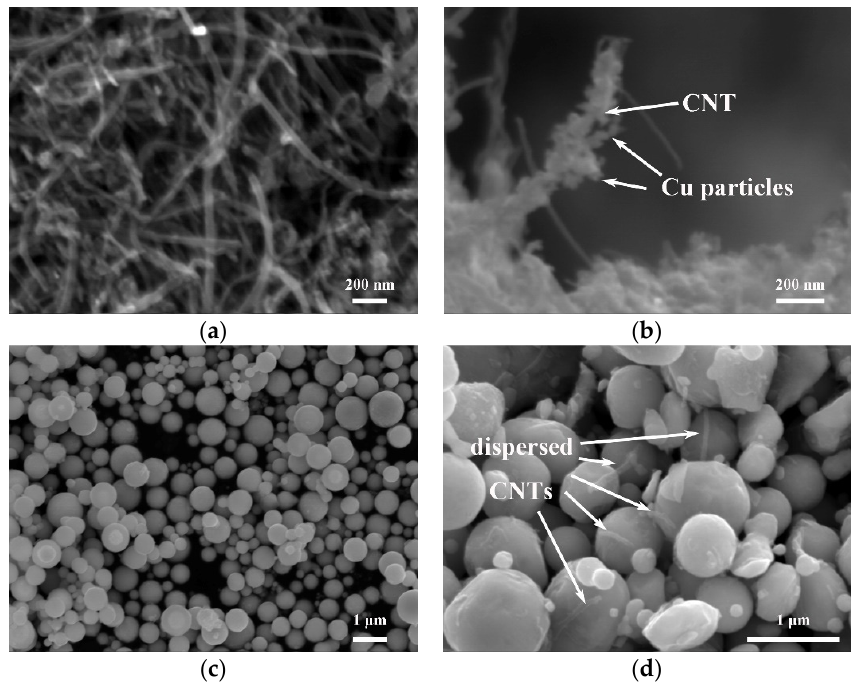
Figure 2. SEM images of ( a ) as-received CNTs, ( b ) Cu-coated CNTs, ( c ) pure Cu powder, and ( d ) mixture of CNT and Cu